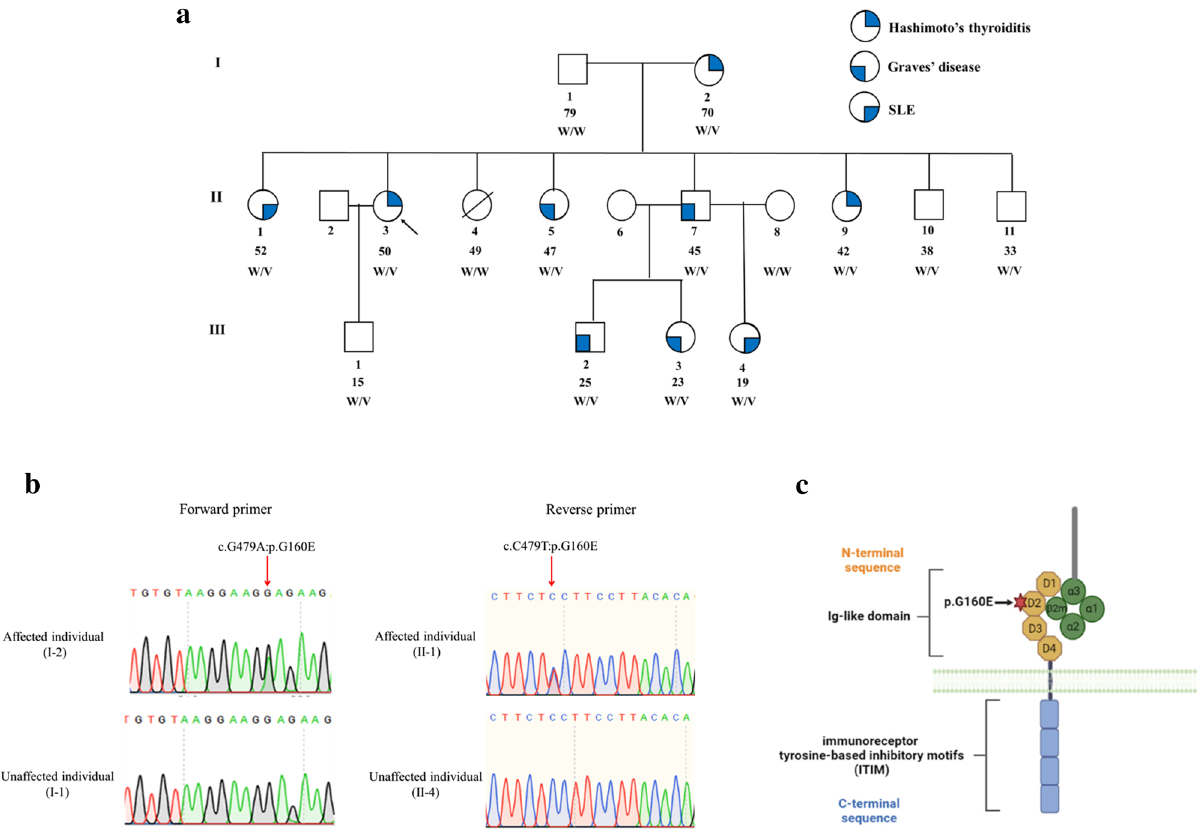
Figure 1. Whole-genome linkage analysis and exome sequencing identified a variant in LILRB1 to be associated with familial autoimmune disease. ( a ) The family pedigree includes a symbolic presentation of the three clinical features of Hashimoto’s thyroiditis, Graves’ disease, and SLE. An arrow indicates the proband. The Roman numerals at the left side represent generations. Numbers immediately below individual’s symbols indicate individual’s order in the generation. Numbers below the individual’s order denote ages. W, wild-type allele. V, variant. ( b ) Sanger sequencing demonstrates a heterozygous missense c.479G > A (p.G160E) variant in LILRB1 . ( c ) Structure of LILRB1 receptor. The arrow shows the p.G160E is located on the immunoglobulin-like domain (Ig-like C2-type ing tyrosine phosphorylation of LILRB1 13 . Western blot analysis revealed decreased phosphorylation levels of SHP-1 in Jurkat cells transfected with MT LILRB1 , compared with those transfected with WT one (Fig. 2c,d). In addition, immunoblot using antibody array of human phospho-proteins at 10 min showed decreased phospho- rylation levels of both LILRB1 and SHP-1 (Fig. 2e,f). These findings indicated that p.G160E mutation impaired LILRB1 phosphorylation ability, which in turn reduced SHP-1 phosphorylation, implying that this variant in LILRB1 gene caused a loss-of-function.